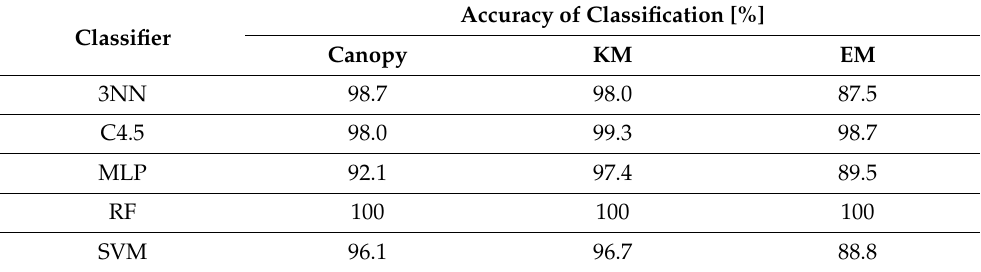
Table 12. The assessment of clusterization of the onion case using the five chosen machine learning methods.